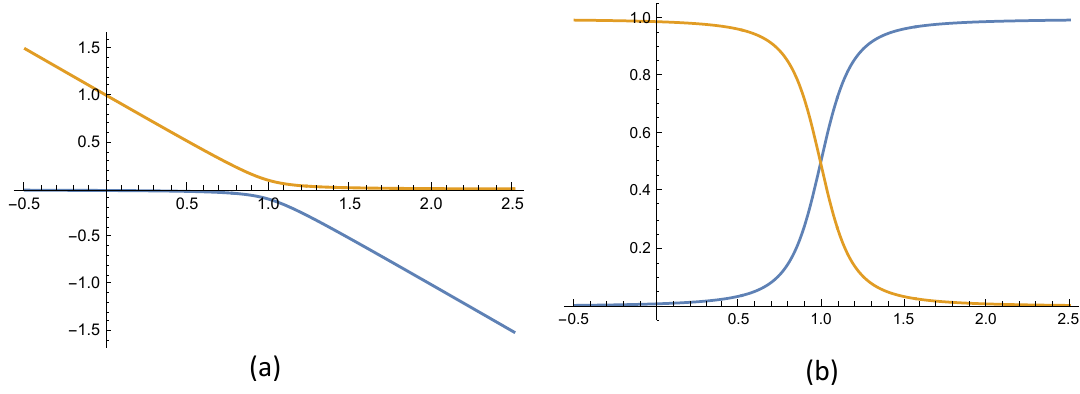
Figure 7 . N f = 1. (a) Evolution of the two eigenvalues of (4.22) for b = 0 : 1 as one varies (cid:22) 2 =a . The lower eigenvalue is tachyonic. (b) Projections of the two corresponding eigenvectors along the PNGB direction. Maximal mixing occurs in the vicinity of the critical point (cid:22) 2 =a =